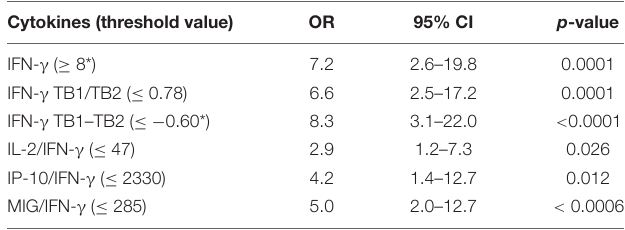
TABLE 3 | Crude odds ratios identifying associations between ATB and interferon-gamma (IFN- γ ) from ESAT-6, CFP-10 stimulated whole blood (QFT). Cytokines (threshold value) OR 95% CI p